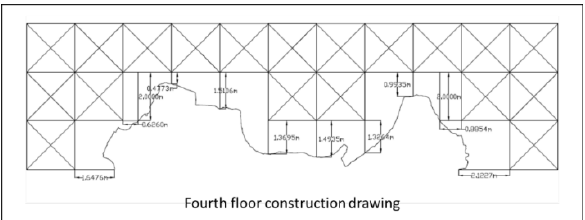
Figure 10. CAD construction drawings